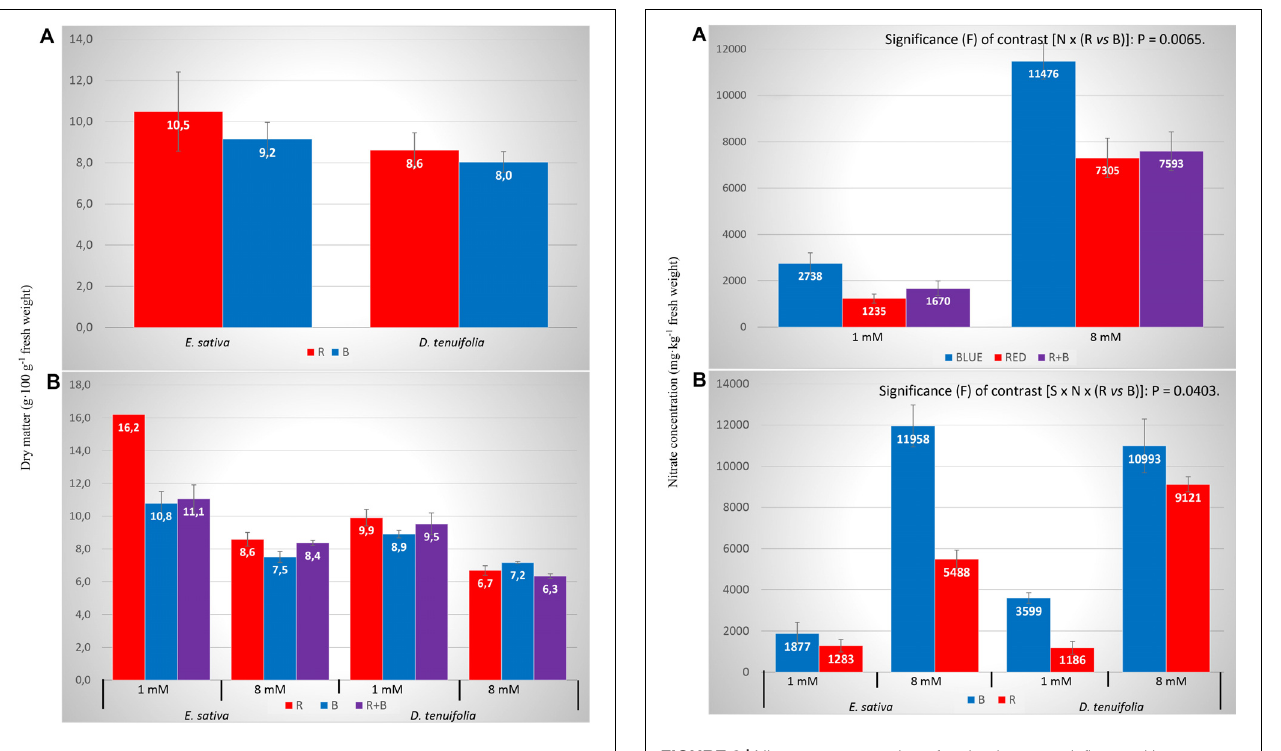
FIGURE 1 | Dry matter percentage of rocket leaves as influenced by interactions between species and light (A) and species, nitrogen level and light (B) . Vertical bars represent the standard error.